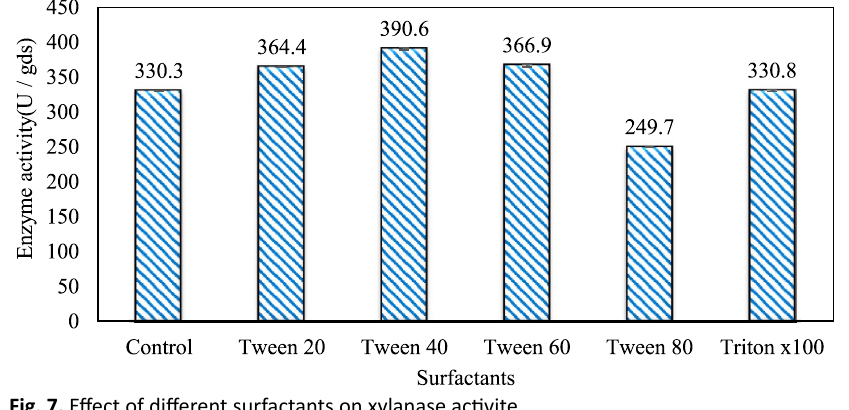
Fig. 7. Effect of different surfactants on xylanase activite